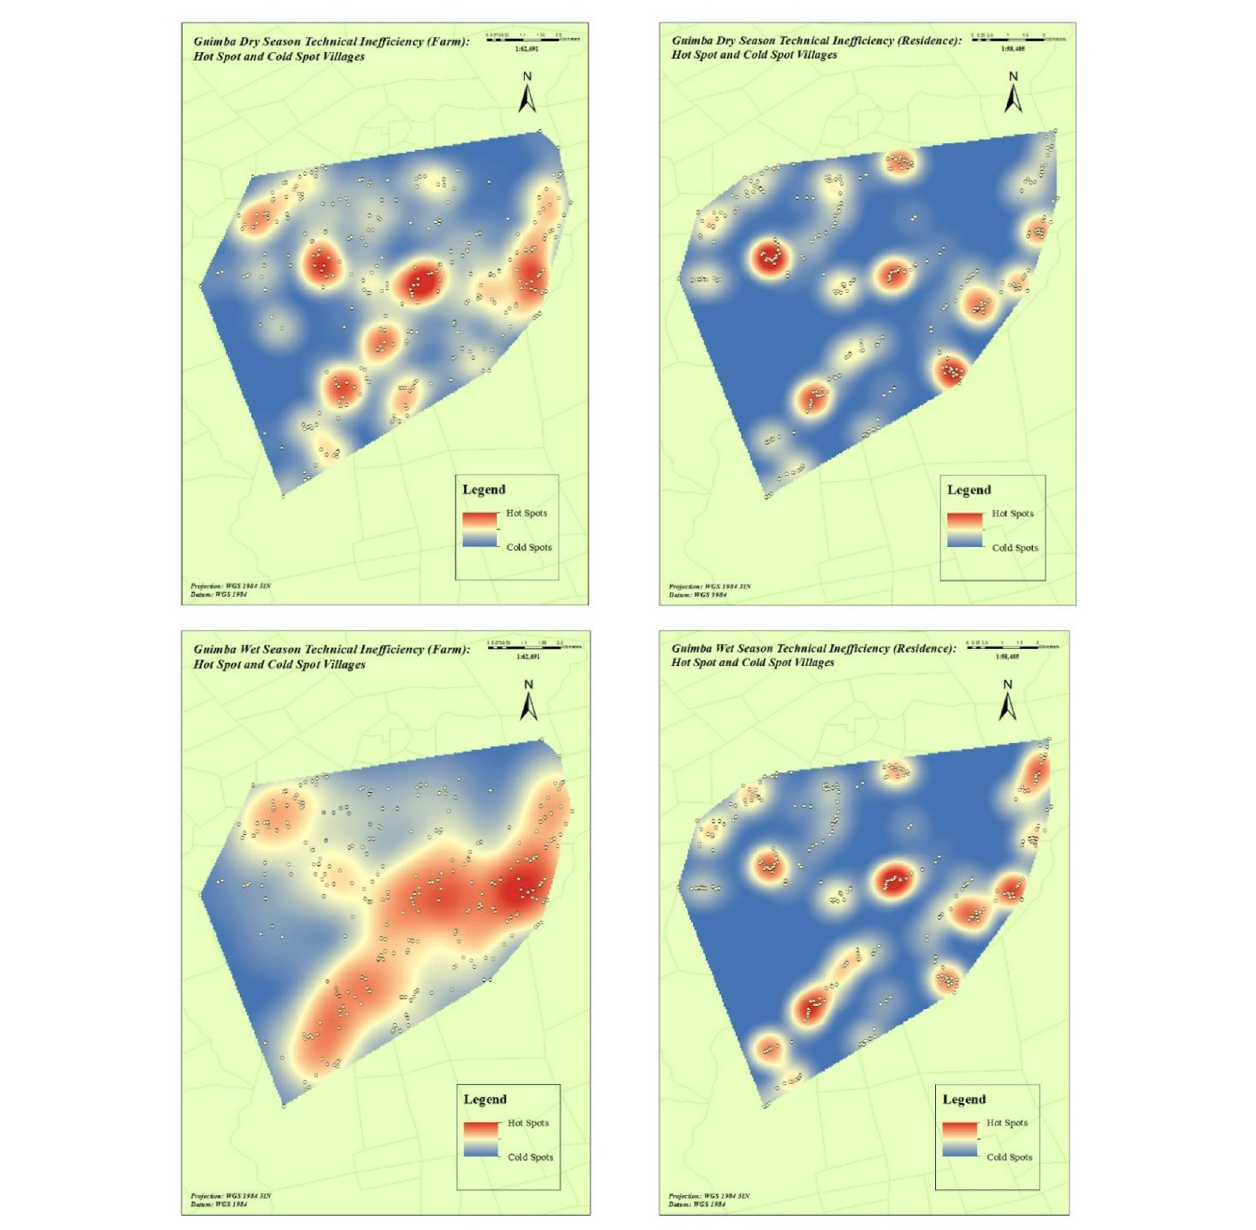
FIGURE 4 | Technical inefficiency hot spot and cold spot for farm areas (left) and dwelling places (right) in Guimba for the dry (top) and wet (bottom) seasons. The visually distinct features between the hot spot maps for technical inefficiency according to geolocations and seasons in Guimba are statistically not